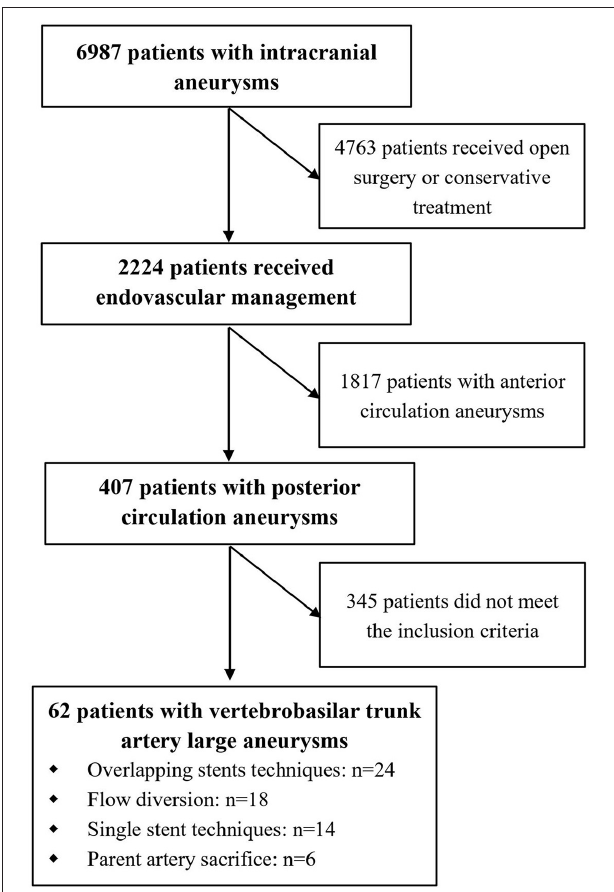
FIGURE 1 | Flowchart of the patient selection